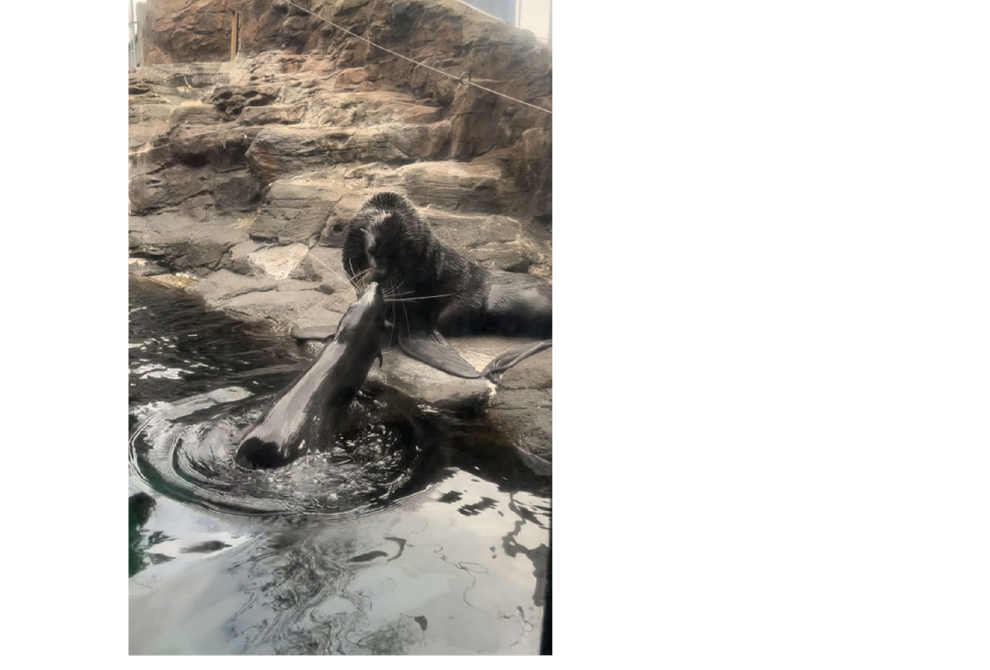
Figure 8. Northern fur seals engaged in Interacting with Another Subject (above: Flaherty, below: Chiidax).